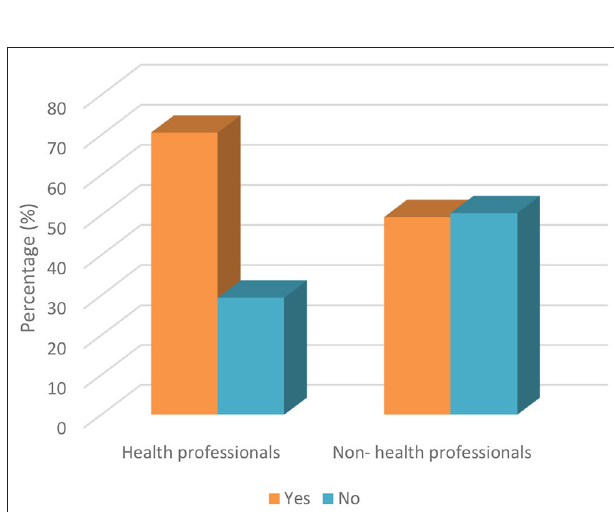
FIGURE 4 | Awareness of participants about conditions requiring urgent dental treatment based on occupation.